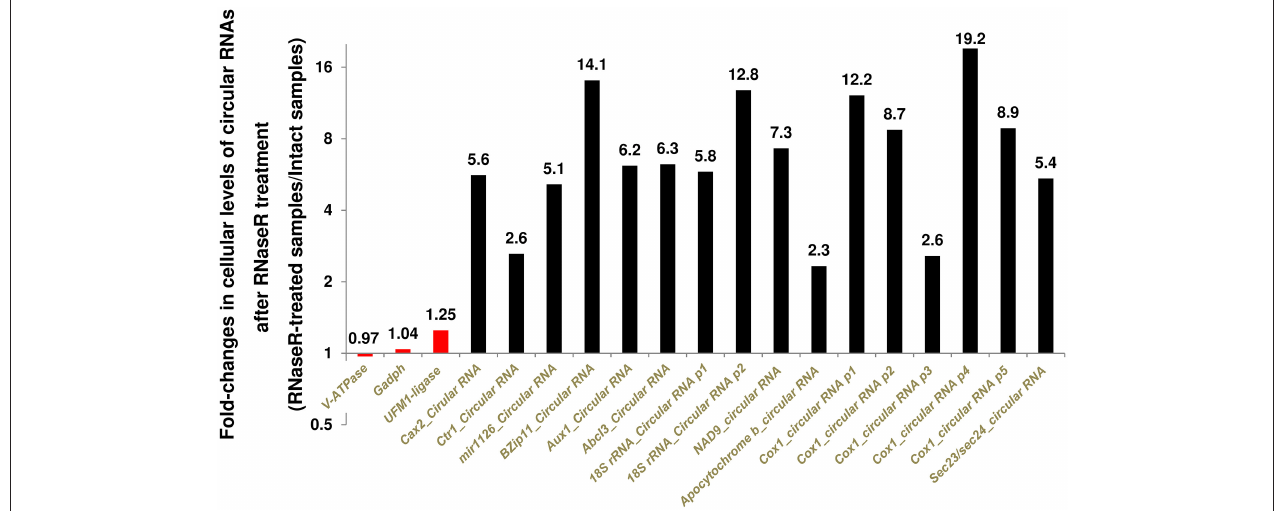
FIGURE 2 | Digestion of Linear RNAs by RNaseR enriched the circular RNAs up to 18 times. The averages of 30 corrected measurements (10 samples with 3 technical replicates) both before and after digestion were applied to examine the RNaseR-resistance of amplicons. In addition to the reference genes, we used UFM1-protein ligase as a negative control. It was a false positive circular RNA candidate supported by a linear transcript with Genbank accession number AK356330. Different divergent primers targeting circular RNA isoforms are shown as p1 to p5. See Table 1 for the gene names.